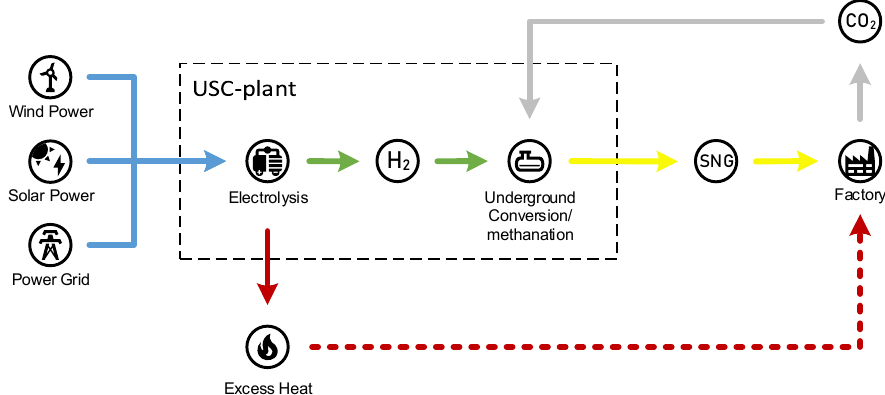
Figure 3. Overview diagram of the use case CCU .